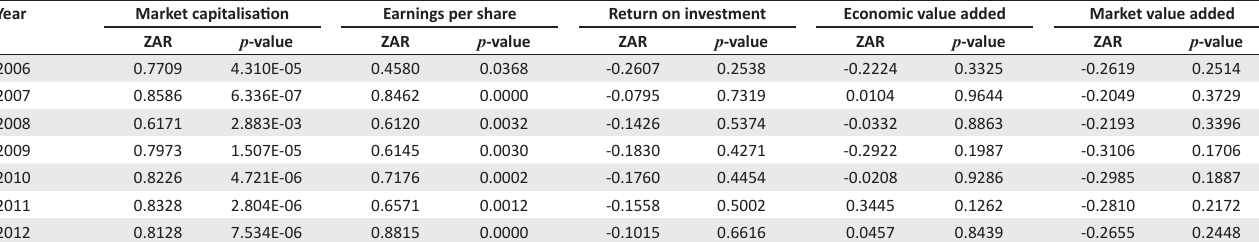
TABLE 6: Correlation analysis: Fixed pay and organisational performance measures. Year